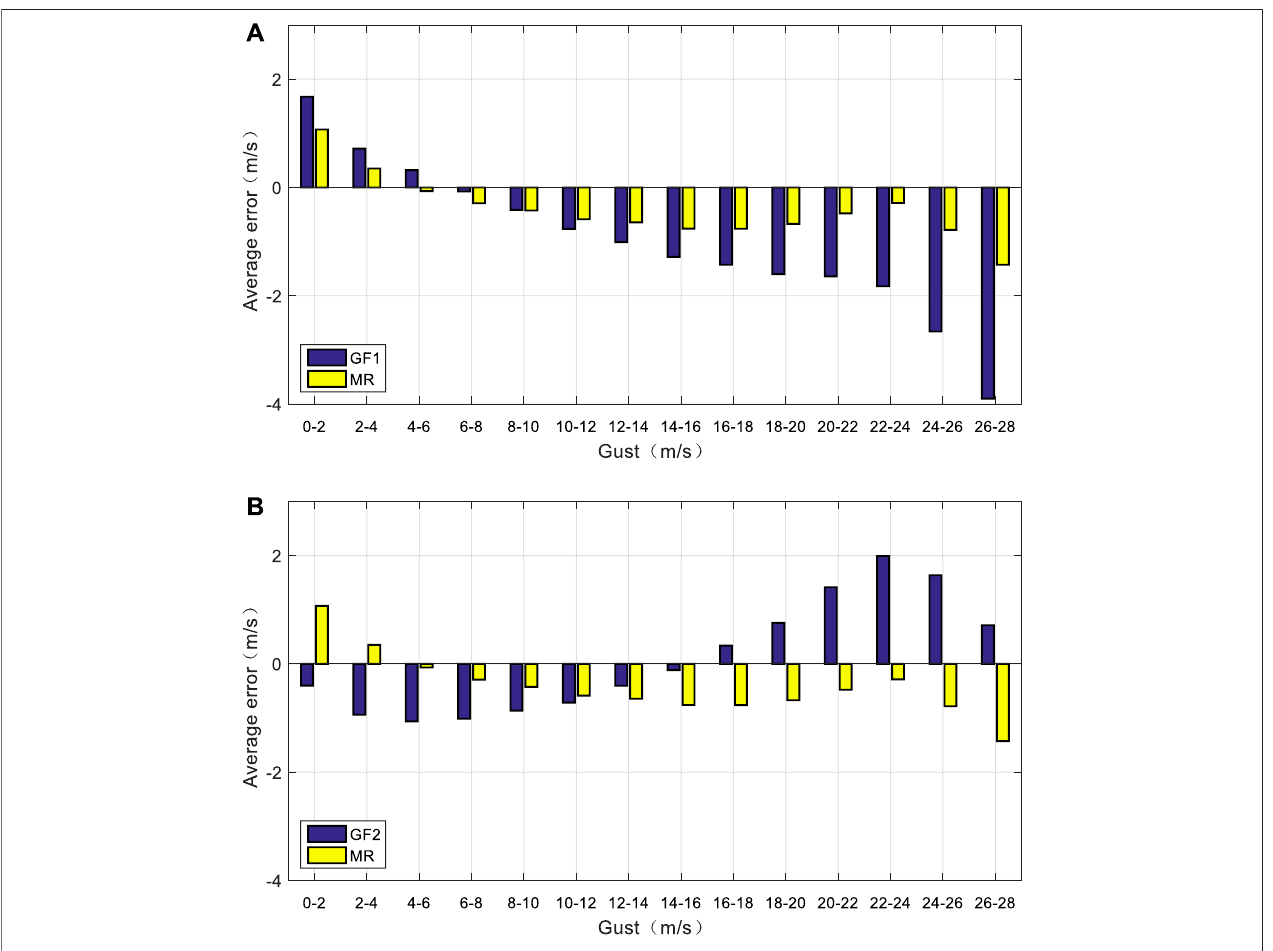
FIGURE 5 | Comparison of mean error in the multiple regression model to that in the (A) gust factor and (B) gust factor 2 models from 2017 to 2019.